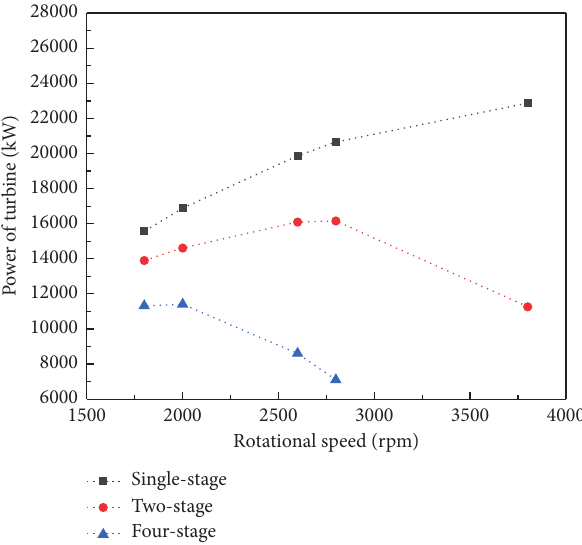
Figure 10: Relationship between output power and rotational speed of large-size turbines.